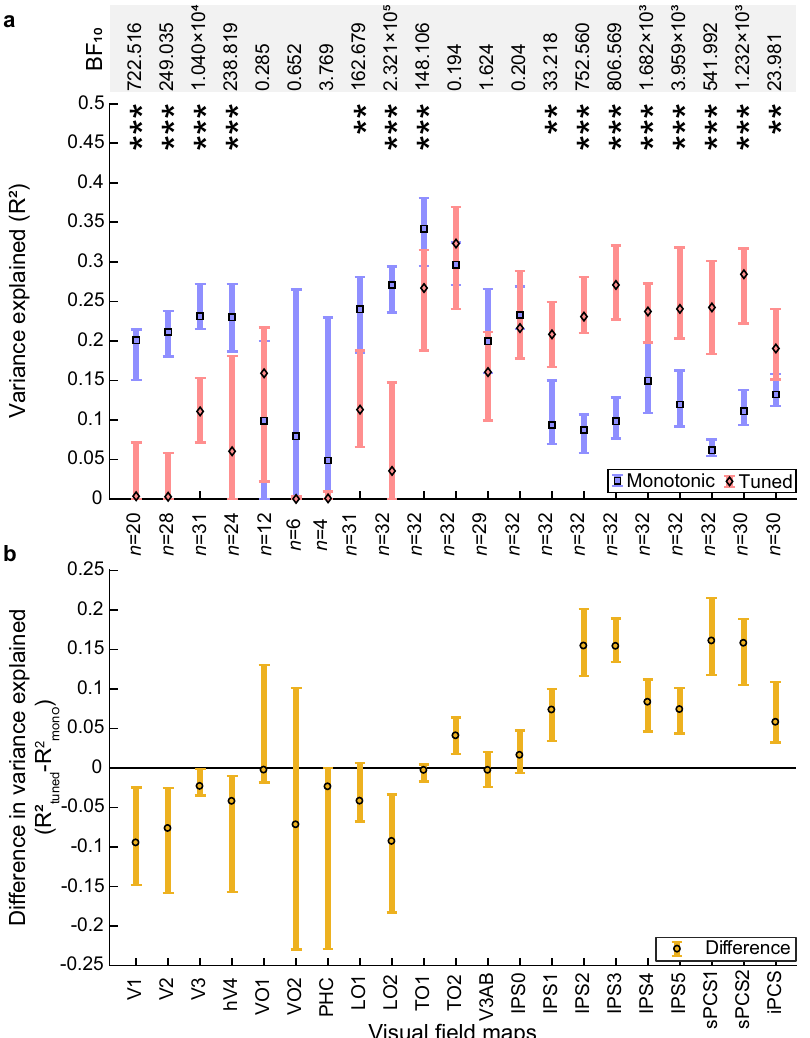
Fig. 3 Comparison of fi ts of monotonic and tuned response models in each visual fi eld map. a Cross-validated variance explained by monotonic and tuned response models. b Difference in cross-validated variance explained between models (tuned – monotonic) progressively changes from monotonic to tuned up the visual hierarchy. Markers show the median variance explained of each visual fi eld map, error bars show the 95% con fi dence interval, computed from 1000 bootstrap iterations. Only the voxels that had a variance explained above 0.2 for the best fi tting model in the data on which the models were fi t are included. Signi fi cant differences between the models (two-sided Wilcoxon signed-rank test, false discovery rate (FDR) corrected for multiple comparisons): * p < 0.05 ** p < 0.01, and *** p < 0.001. n indicates the number of hemispheres included in the comparison in each visual fi eld map (for both panels). Bayes factors (BF 10 ) for each paired comparison are presented in the top row. Source data are provided as a Source Data fi